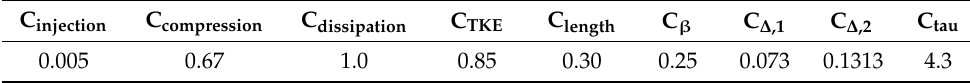
Table 9. Calibrated constants for the K-k turbulence